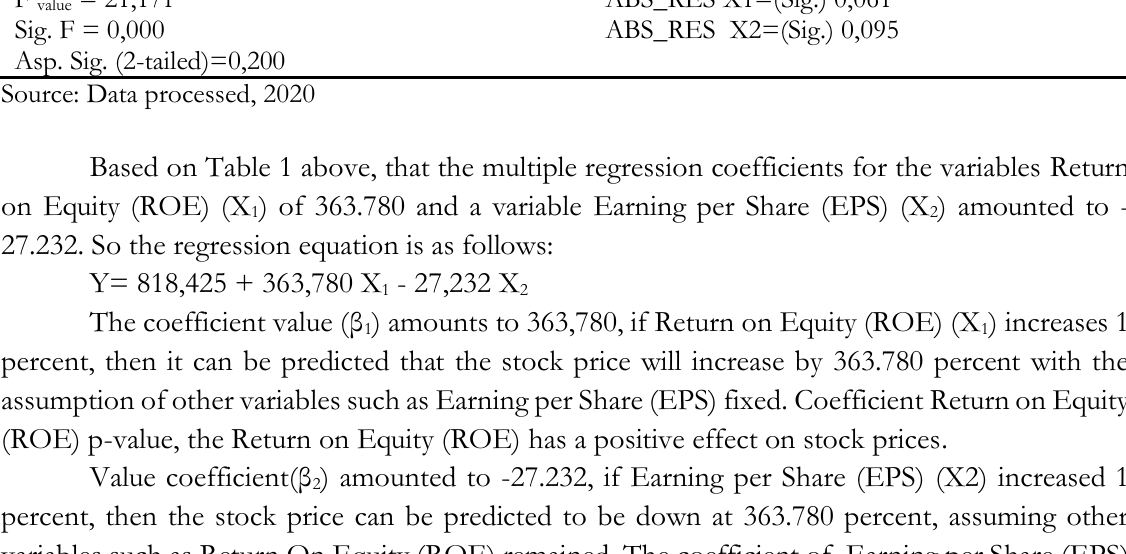
Figure 1. Conceptual Framework